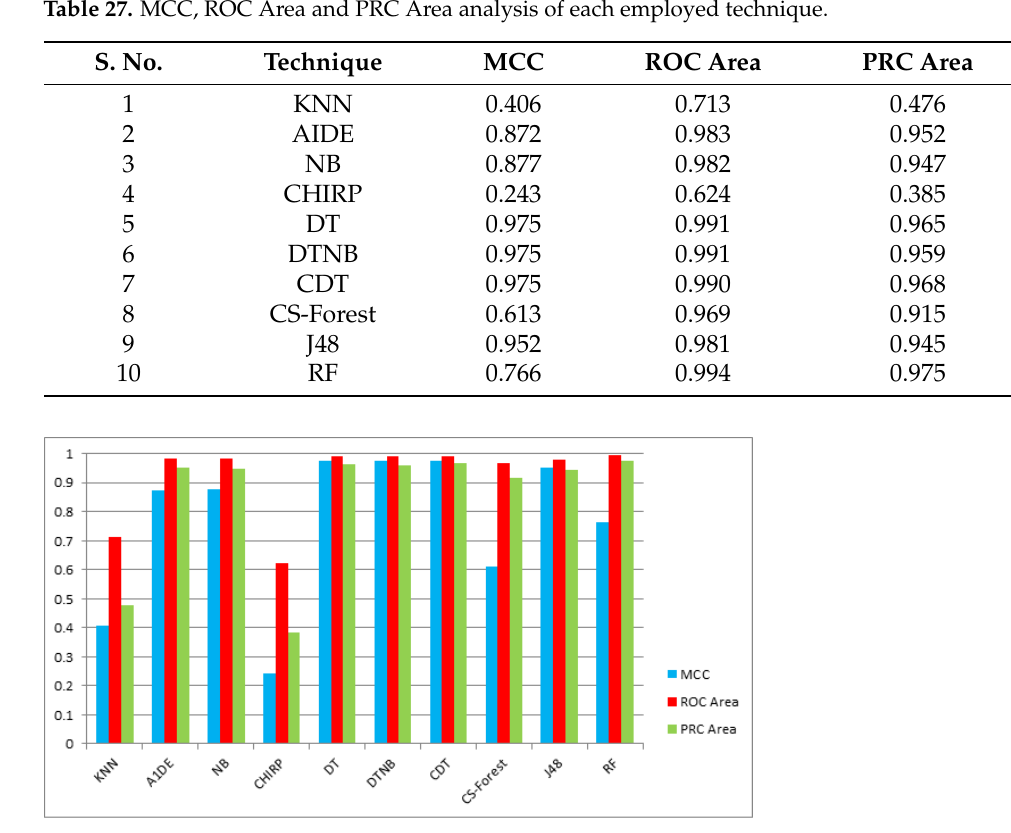
Figure 6. MCC, ROC Area and PRC Area analysis of individual technique.